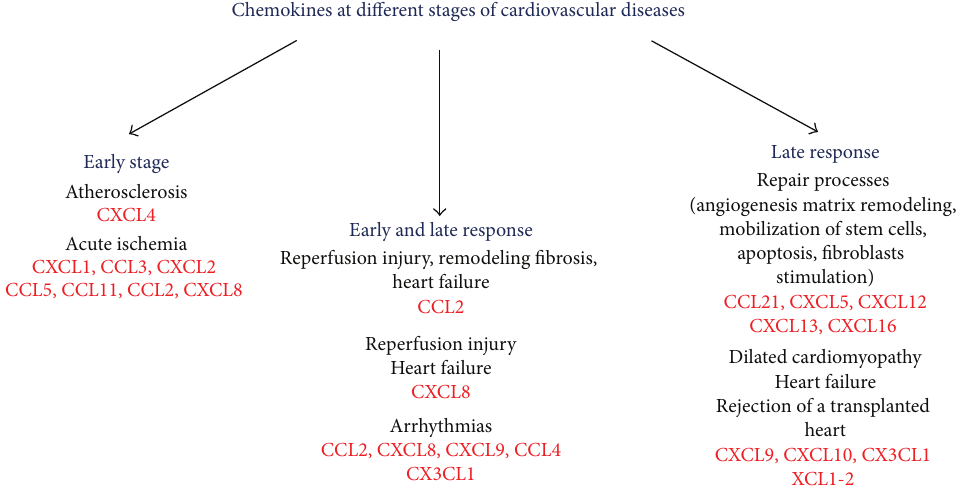
Figure 1: Association between chemokines and pathological conditions present in cardiovascular diseases. Some chemokines play a role in the early stages of cardiovascular disease, being associated with atherosclerosis and acute myocardial ischemia. CCL2 and CXCL8 are involved in both early and late response to ischemic injury, recruiting leukocytes after acute ischemia and playing a role in heart failure. Moreover, together with other chemokines, they are strongly associated with cardiac arrhythmias, a dangerous event which may occur at all stages of the disease. Finally, there are chemokines frequently found in the late response to injury and in the repair process and chemokines more associated with dilated cardiomyopathy and chronic rejection of a transplanted